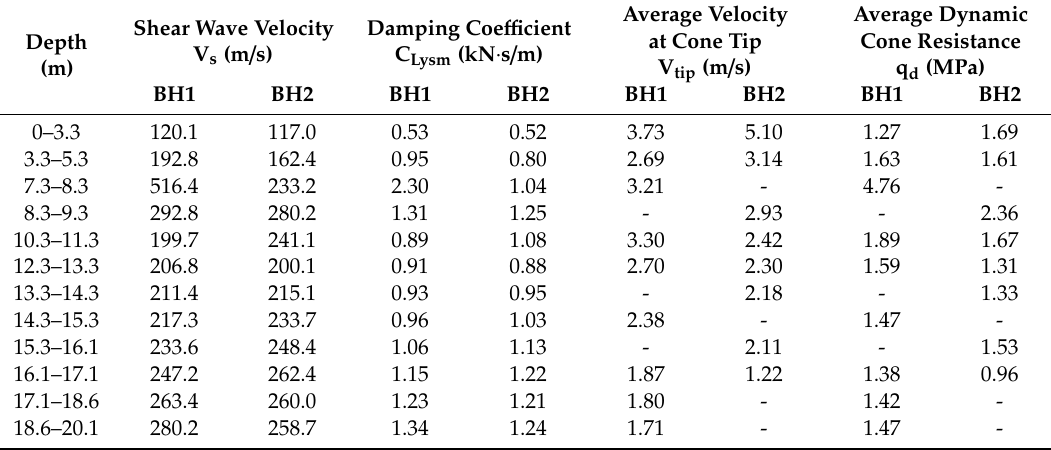
Table 3. Estimation of the dynamic cone resistance based on Lysmer’s